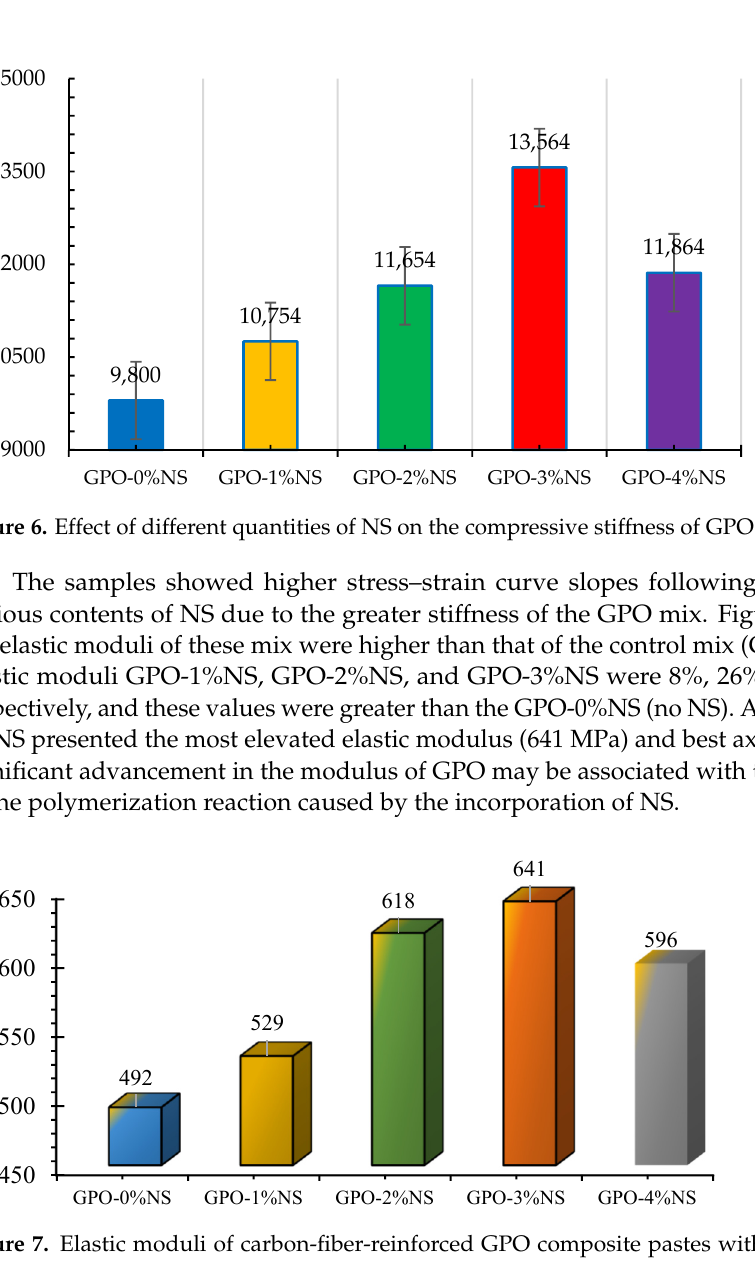
Figure 5. Compressive stress–strain efficacy of carbon-fiber-reinforced GPO composite paste with various contents of NS.